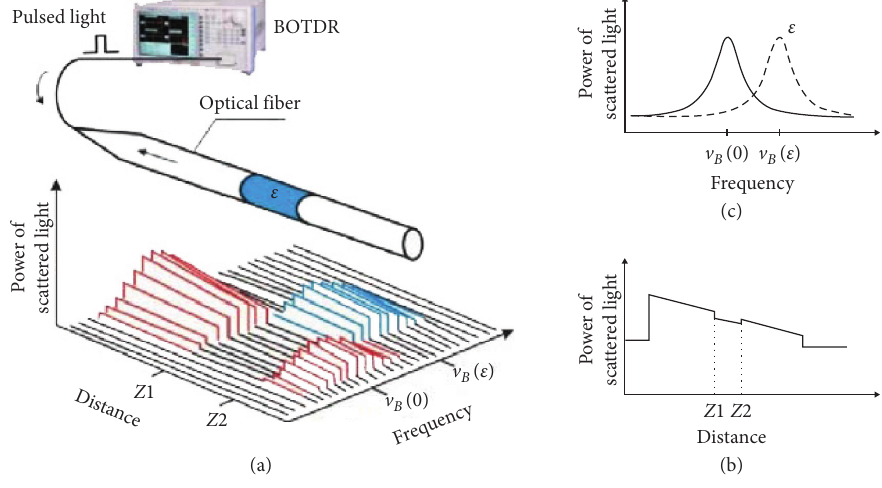
Figure 1: Schematics of strain measurements with